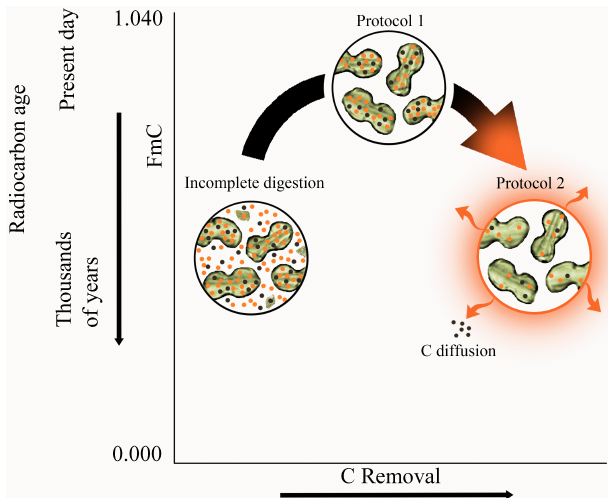
Figure 7. Conceptualization of the impact of phytolith extraction aggressiveness and C removal on 14 C age of phytoliths. Incomplete digestion leads to an accumulation of old residual OM in phytolith concentrates. Protocol 1 removes all OM residues and better pre- serves the dual source phytC signature. Protocol 2 removes all resid- ual OM and labile (intrinsically young) phytC. For illustration pur- poses, young and old C are represented by black and orange dots, respectively (see Fig.